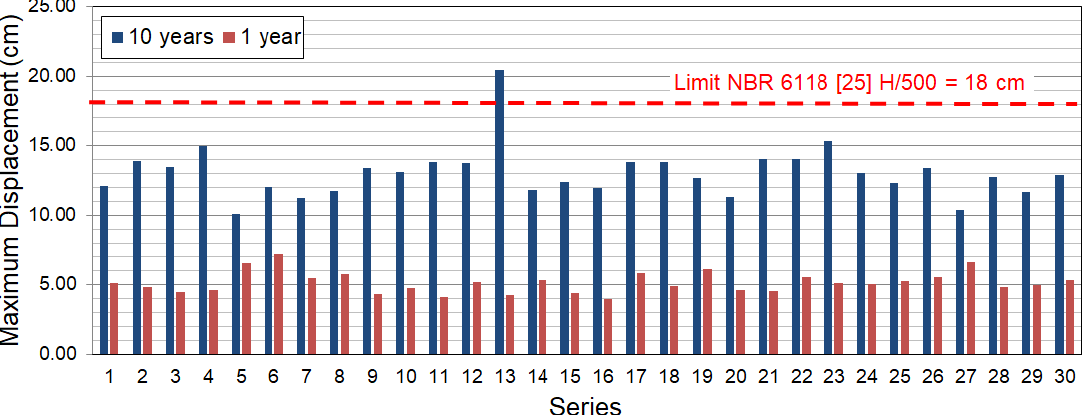
Figure 15. Maximum translational horizontal displacements obtained for each nondeterministic wind series based on a period of recurrence equal to 10 years and 1 year.